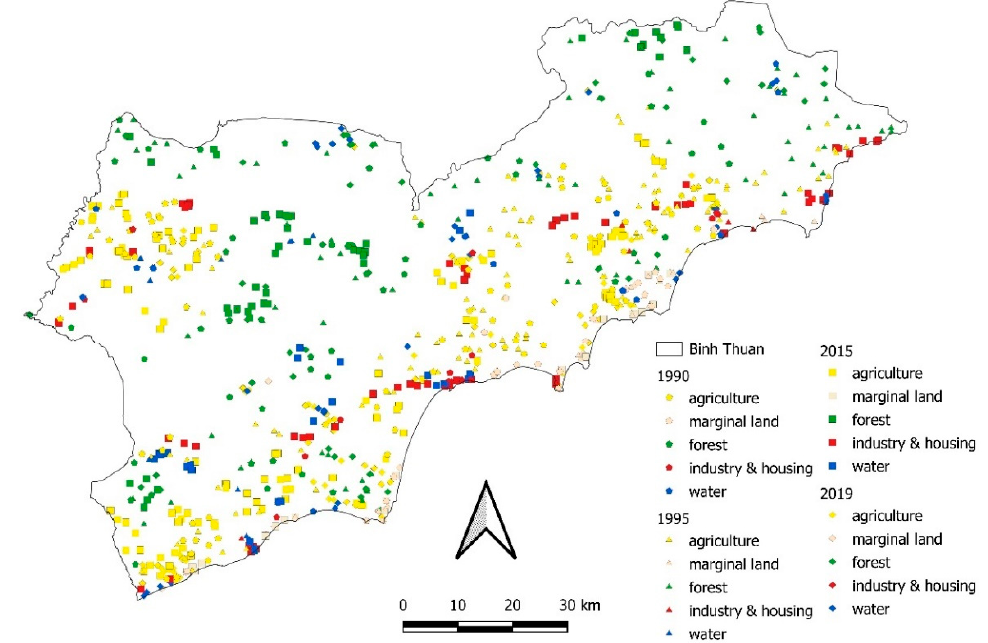
Figure A2. Training samples for land cover classification in Binh Thuan province for selected years (1990–2019).